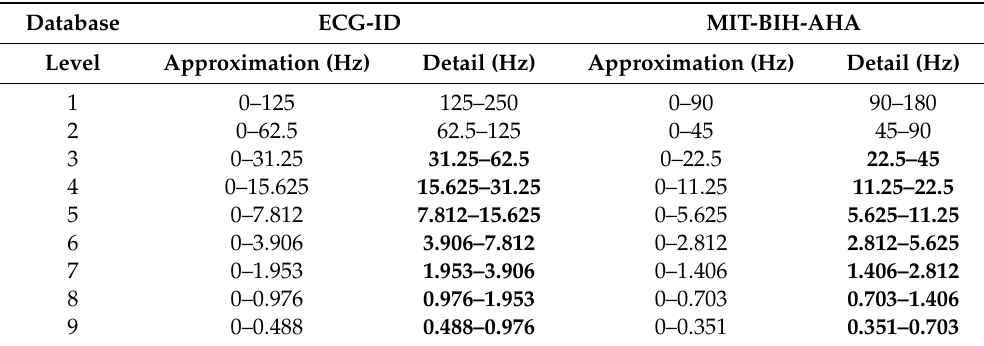
Table 1. Estimated frequency of coefficients from different levels.